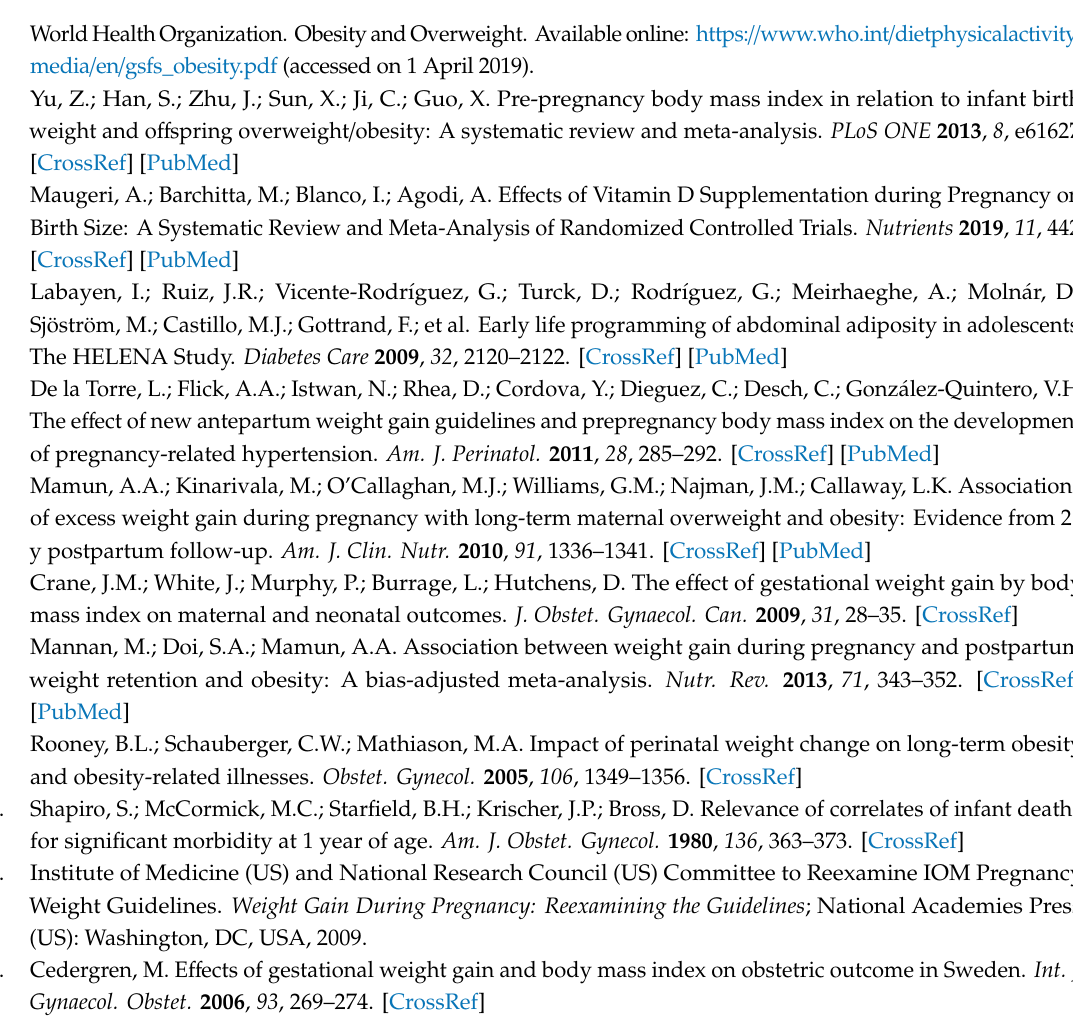
Figure S1: Scree plot of the eigenvalues, Table S1: Food grouping used in the dietary pattern analysis, Table S2: Factor loadings which characterized dietary patterns in two randomly selected subgroups ( n = 100) from the “Mamma & Bambino”